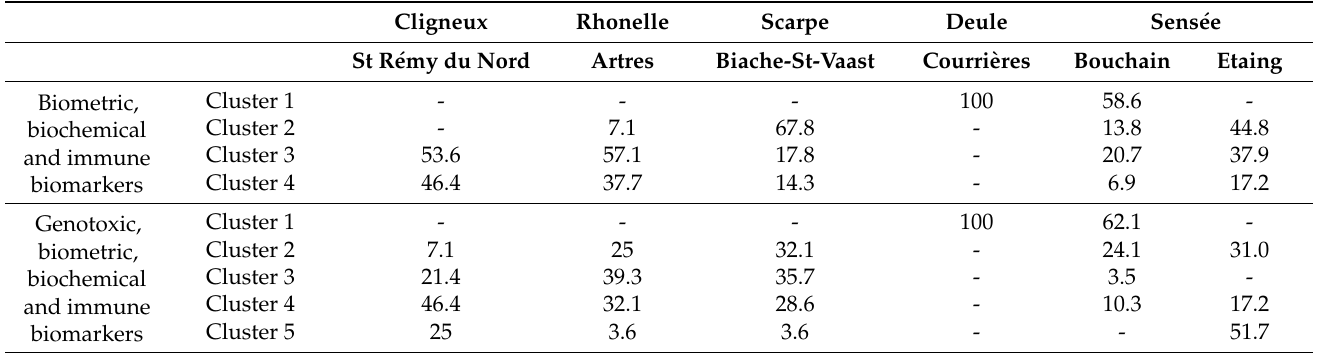
Table 3. Composition of the sites using biometric, biochemical and immune biomarkers alone and with the inclusion of genotoxicity. Results are presented as percentages of fish classified in each cluster for each site. Cligneux Rhonelle Scarpe Deule Sens é e St R é my du Nord Artres Biache-St-Vaast Courri è res Bouchain